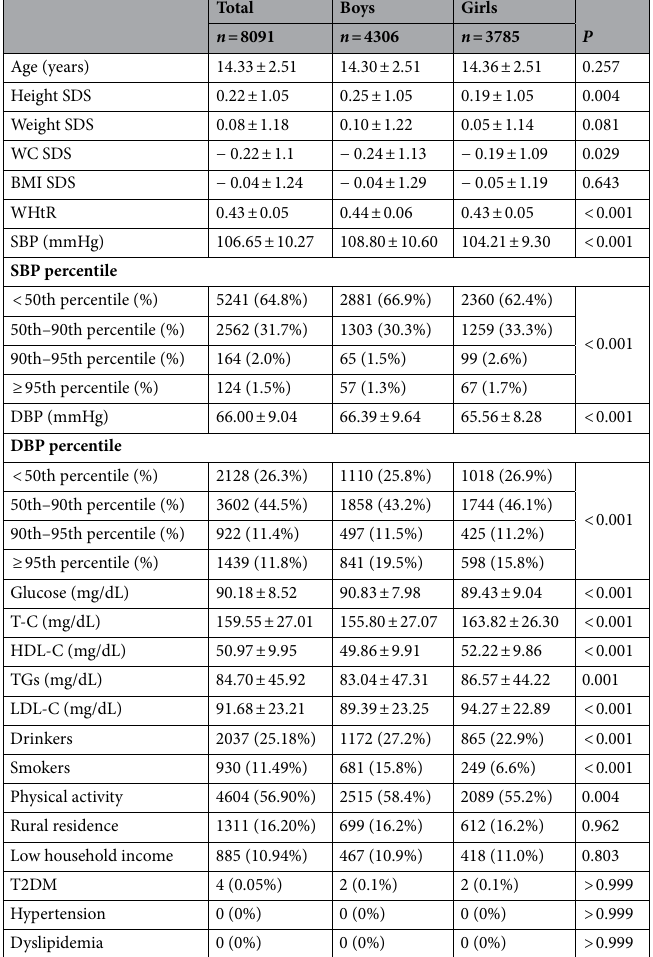
Table 1. Clinical characteristics of the study population ( n = 8091). The results are expressed as the mean ± standard deviation (SD) or n (%). Drinkers consumed at least two alcoholic beverages/month during the previous year; smokers smoked more than five packs of cigarettes throughout their lives; physically active individuals met at least one of the following criteria: (1) intense physical activity for 20 min at least three days/week, (2) moderate physical activity for 30 min at least five days/week, or (3) walking for 30 min at least five days/week. SDS standard deviation score, WHtR waist circumference-to-height ratio, BMI body